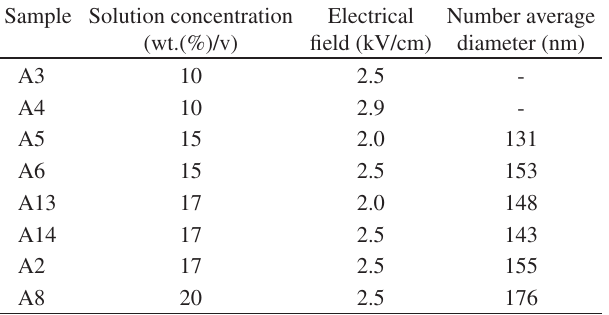
Table 2. Electrospinning conditions of sample A.